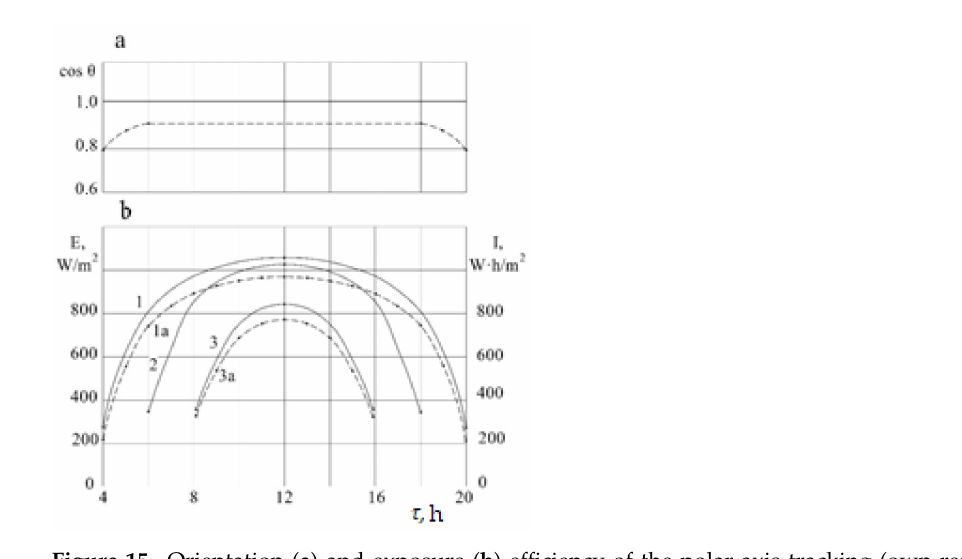
Figure 15. Orientation ( a ) and exposure ( b ) efficiency of the polar-axis tracking (own research): continuous lines—at combination of the normal with the direction to the Sun; dash line—at a seasonal deflection of the normal from the Sun at the angle δ = ± 23.45 ◦